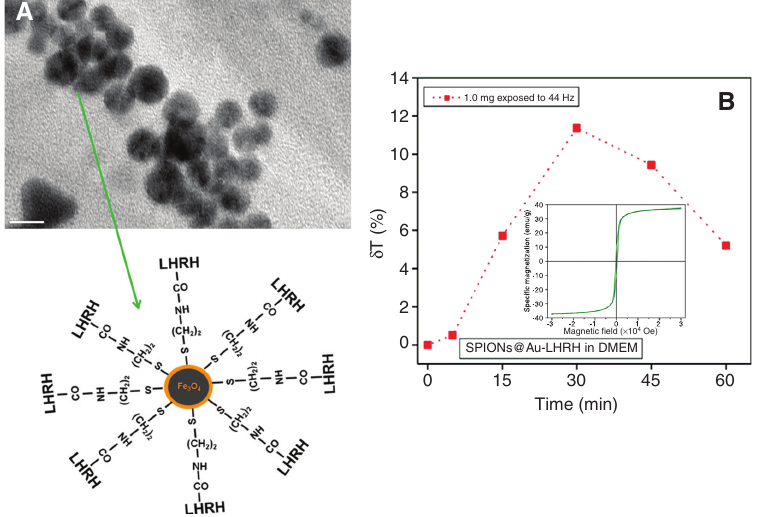
Figure 2 (A) High-resolution transmission electron microscopy (HRTEM) image of SPIONs@Au-LHRH (size = 6.7 ± 0.8 nm) and its schematic representation. (B) Heat release by SPIONs@Au-LHRH in DMEM over a period of 60 min when exposed to a magnetic field strength of 465 Oe (frequency: 44 Hz) and inset showing the magnetic hysteresis curve with an Ms of 32